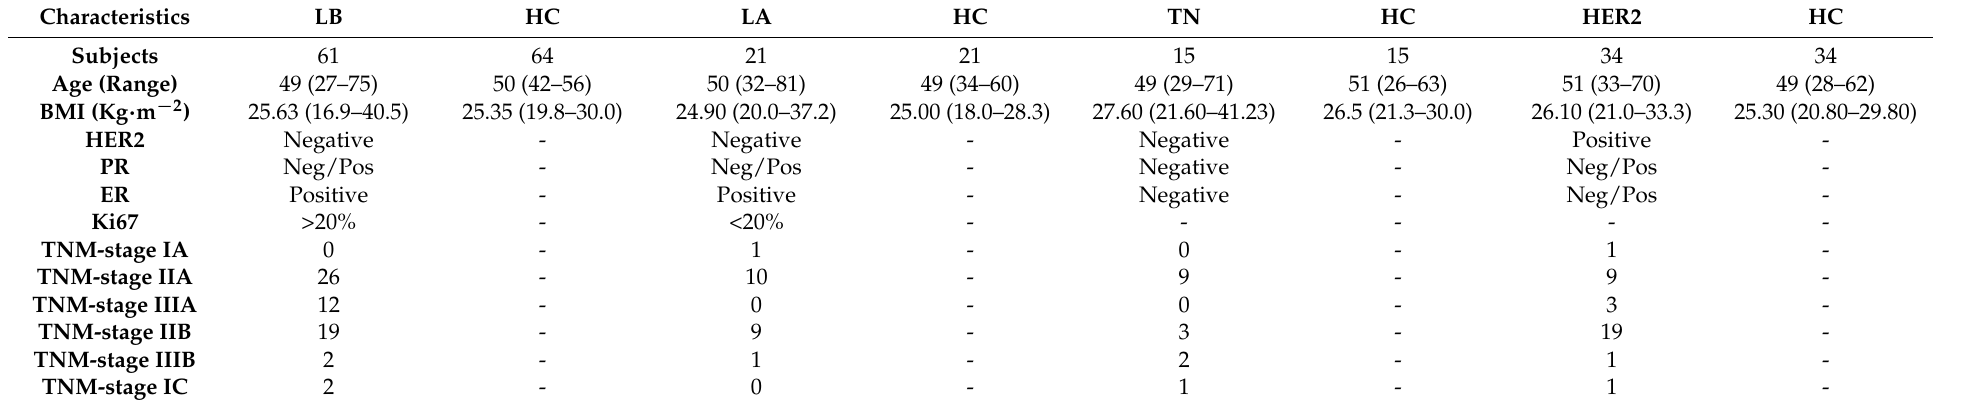
Table 4. Demographic and clinical characteristics of breast cancer patients and healthy control